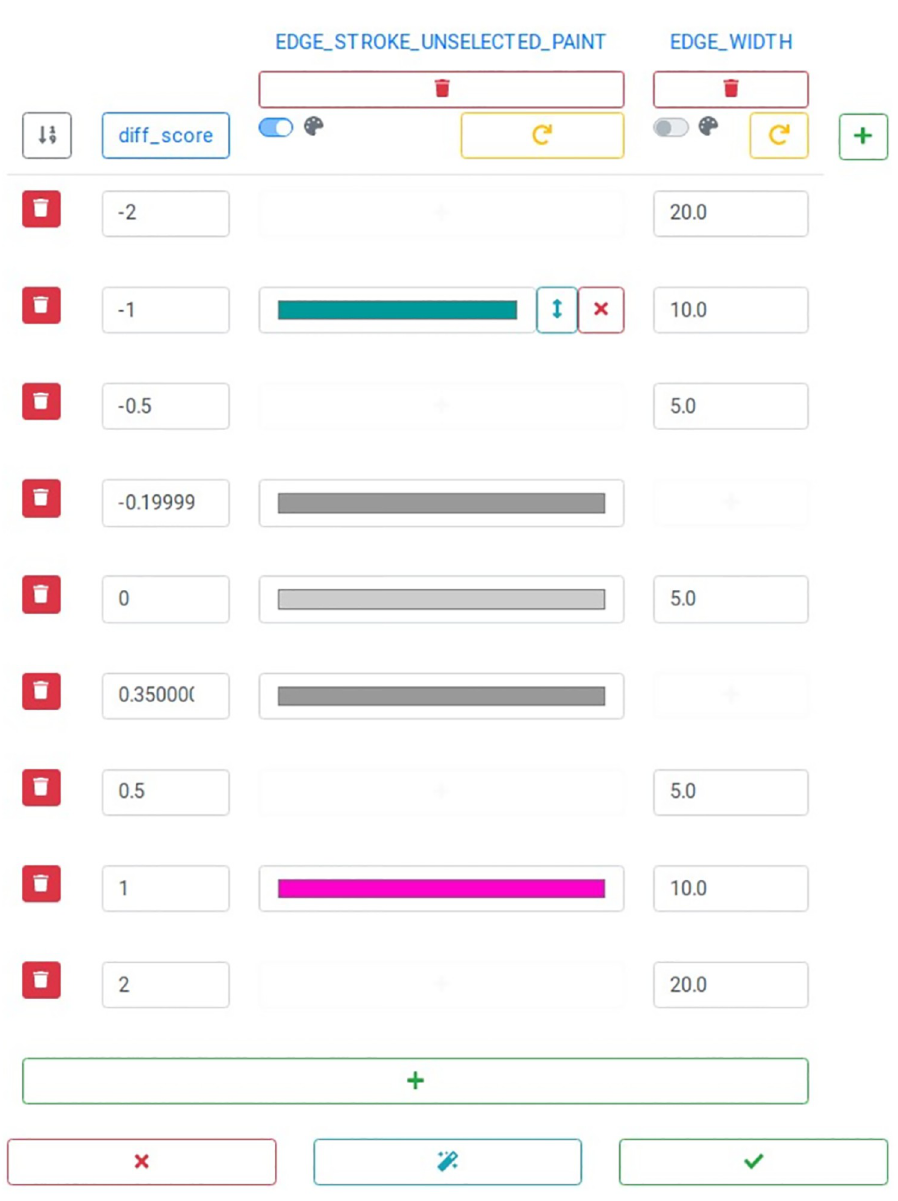
Fig 3. Edit continuous mappings. The score values of the edges are mapped using boundary values, to which colors and numeric values can be assigned. Mapping properties and boundaries can be deleted or new ones added.